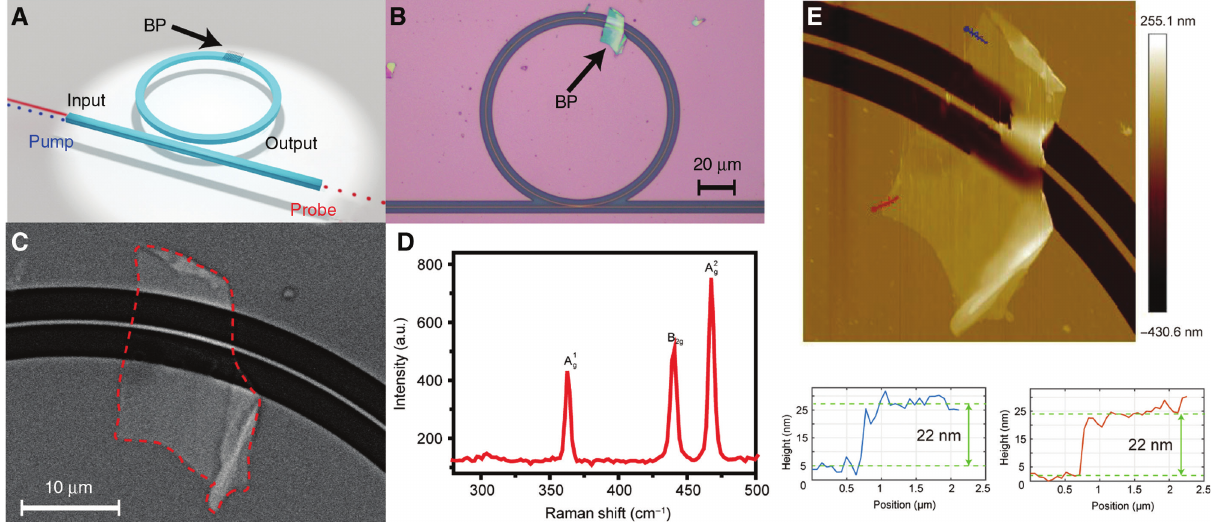
Figure 1: Structure and characterization of the BP modulator. (A) Three-dimensional schematic illustration of the BP/MRR hybrid all-optical modulator. The probe light (red) and pump light (blue) are both coupled into the MRR waveguide. (B) Top-view microscope image of the device. (C) SEM snapshot of the BP-MRR hybrid structure. The red dashed curve indicates the boundary of the BP thin layer. (D) Raman spectrum of the BP material of the device. (E) The thickness measurement results using an AFM. The average thickness of the BP is 22 nm.